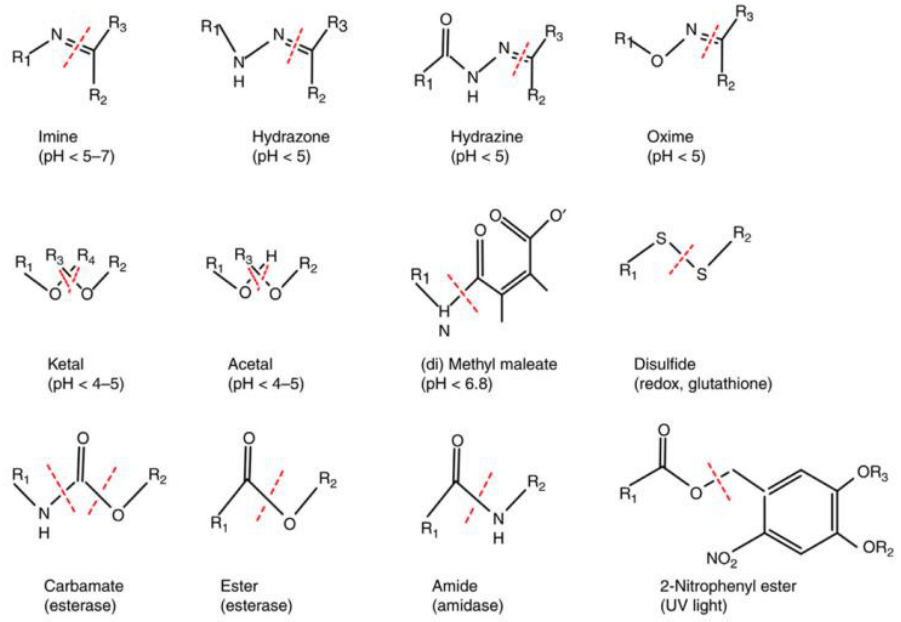
Figure 6. Chemical bonds used to develop stimuli-responsive systems [25]. Reprinted with permis- sion from ref. [25]. Copyright 2017 Elsevier.